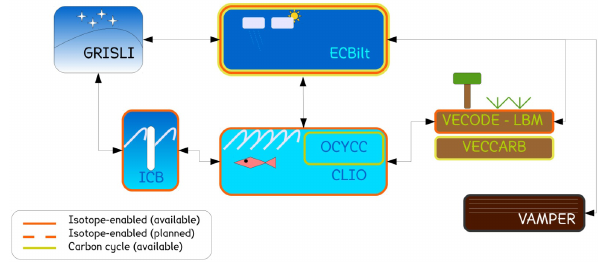
Figure 2. i LOVECLIM model component